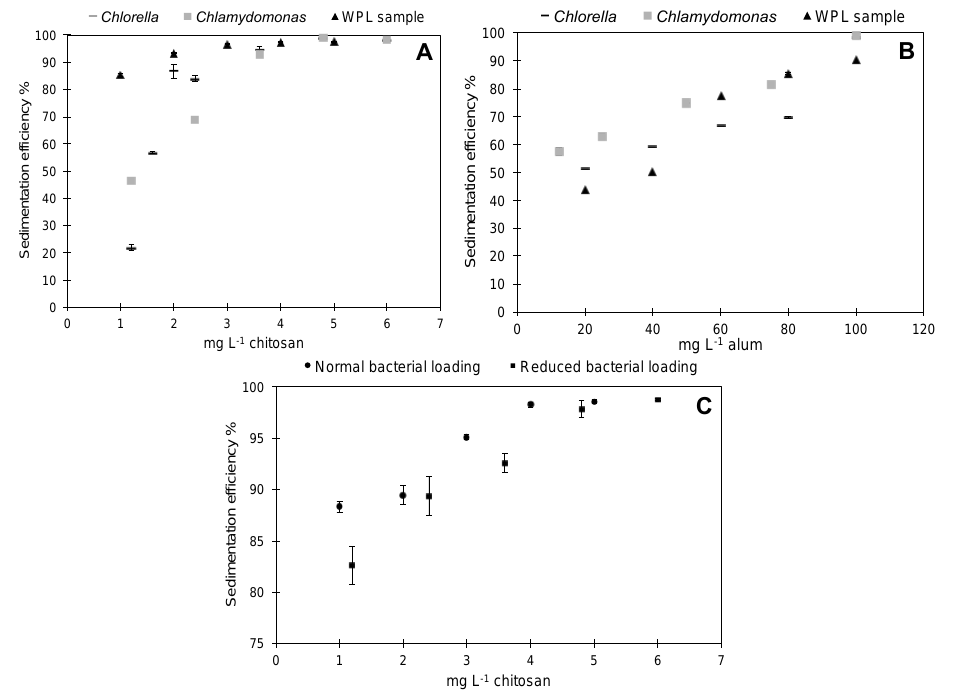
Figure 1. Preliminary sedimentation efficiency experiments using ( A ) Chitosan with Chlorella , Chlamydomonas and WPL sample, ( B ) Alum with Chlorella , Chlamydomonas and Weston Park Lake (WPL) sample and ( C ) Chitosan with WPL sample with normal and reduced bacteria concentration (error bars are standard deviation n = 3).